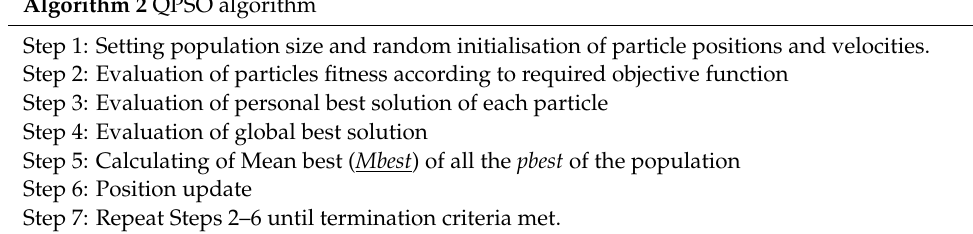
Algorithm 2 QPSO